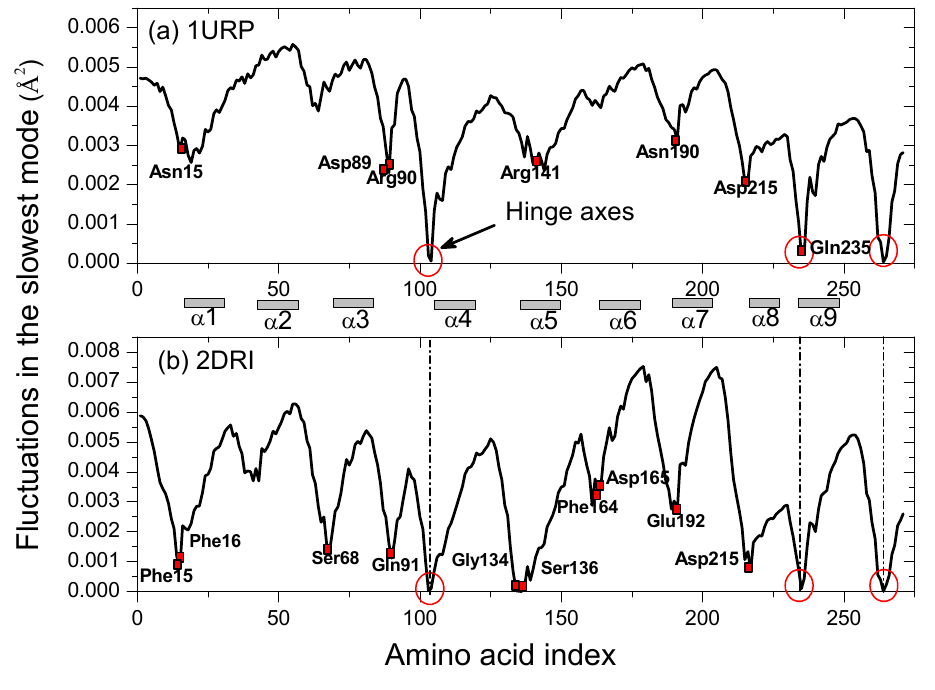
Figure 3. Comparison of the mean square fluctuations due to slowest mode for ( a ) 1URP and ( b ) 2DRI. The hinge axes are indicated by a red circle. The binding residues and the residues forming hydrogen bonds in the closed structure are marked by a red square.